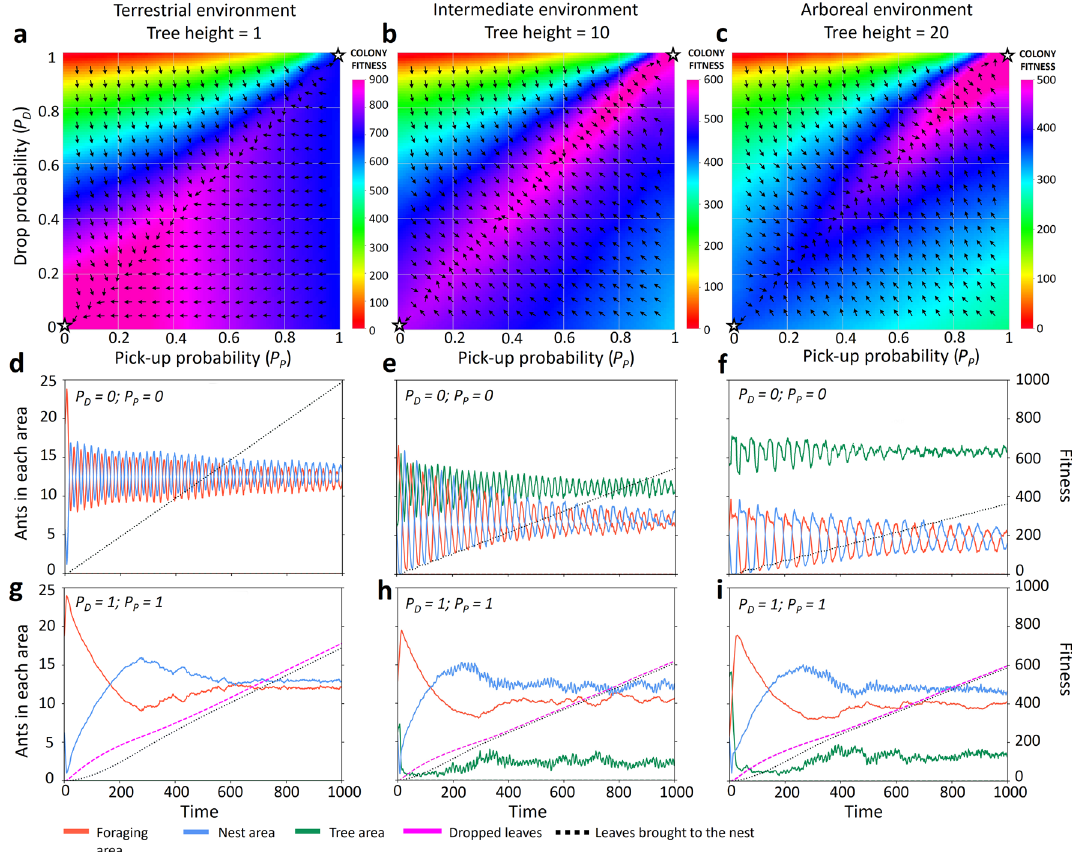
Figure 2. Fitness landscapes and collective movement plots. The topmost graphs show the fitness of colonies foraging in terrestrial ( a ), intermediate ( b ) and arboreal ( c ) environments, depending on pick-up probability ( P P ) and drop probability ( P D ). Colours indicate colony fitness, while the arrows indicate the fitness gradient. Ten replicate simulations were run, averaged, and linearly interpolated for all possible combinations of P P and P D from 0 to 1 with intervals of 0.05 for each environment. The middle graphs ( d , e , f ) show the locations of the ants over the first 1,000 time steps of 50 replicate simulations in each environment for a colony using the generalist strategy ( P P = P D = 0; corresponding to the star in the bottom left corner of the upper graphs), while the bottom graphs ( g , h , i ) show the same for a colony using a fully task-partitioned strategy ( P P = P D = 1; star in the top right corner). In these graphs, ants in the Cache area and the Drop area were respectively included in the counts for the Nest area and Forage area